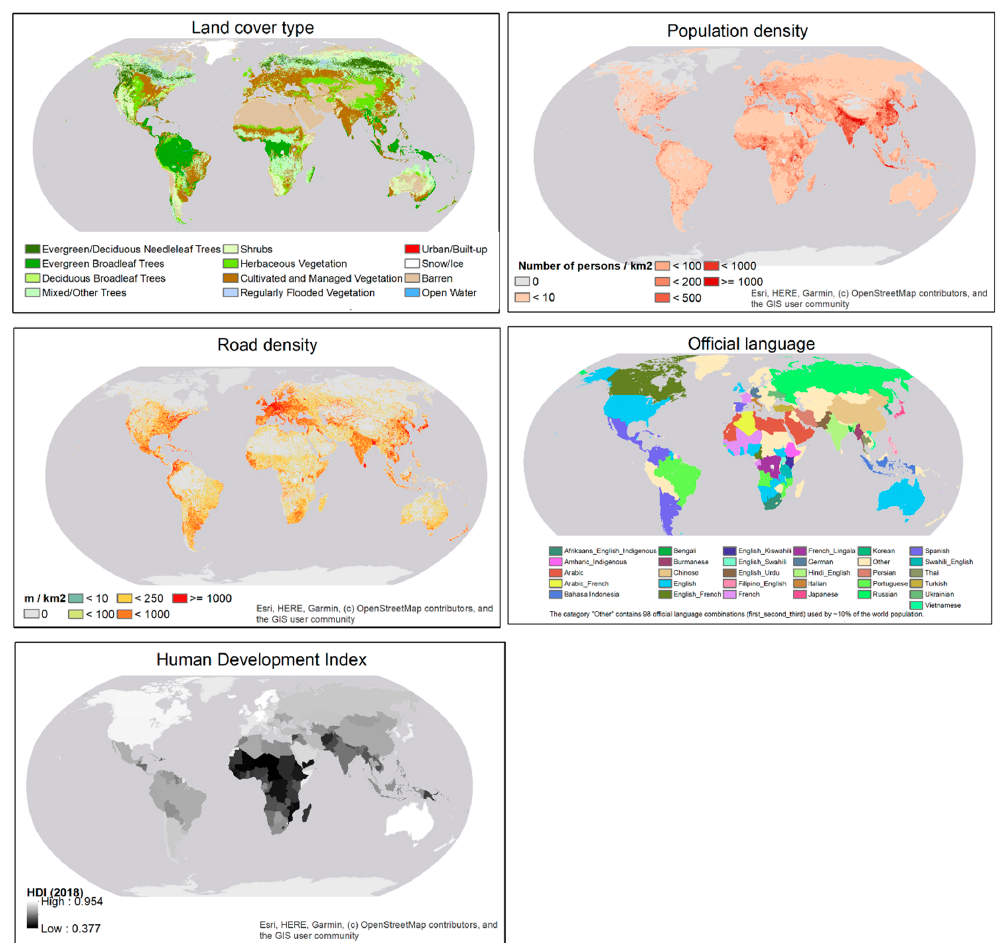
Figure 2. Covariates used for modeling the spatial pattern in sampling efforts of eBird contributors. ISPRS Int. J. Geo-Inf. 2020 , 9 , x FOR PEER REVIEW Frequency distributions of the sampling locations on the covariates were plotted against their respective background frequency distributions (distributions of all covariate values across the world) (Figure 3). The background distribution of the official language covariate was computed as per- language percentages of the 2019 world population at the country level (population data were obtained level HDI values weighted by the population of each country in 2019. Relative frequencies of land cover